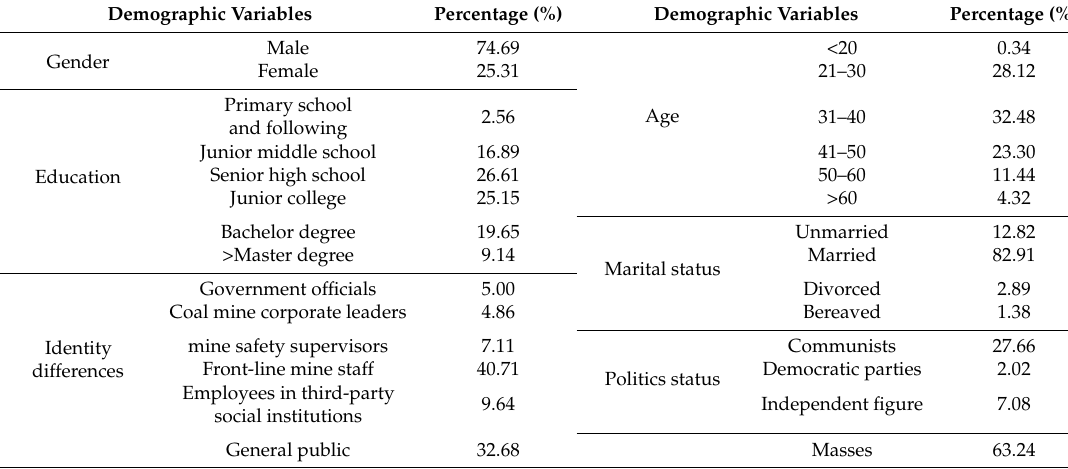
Table 3. The structure of